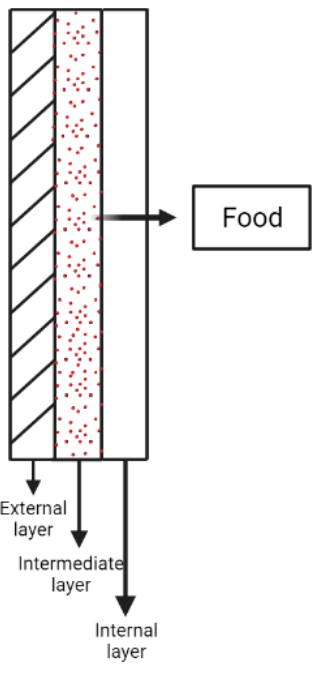
Figure 6. Multilayer packaging structure.